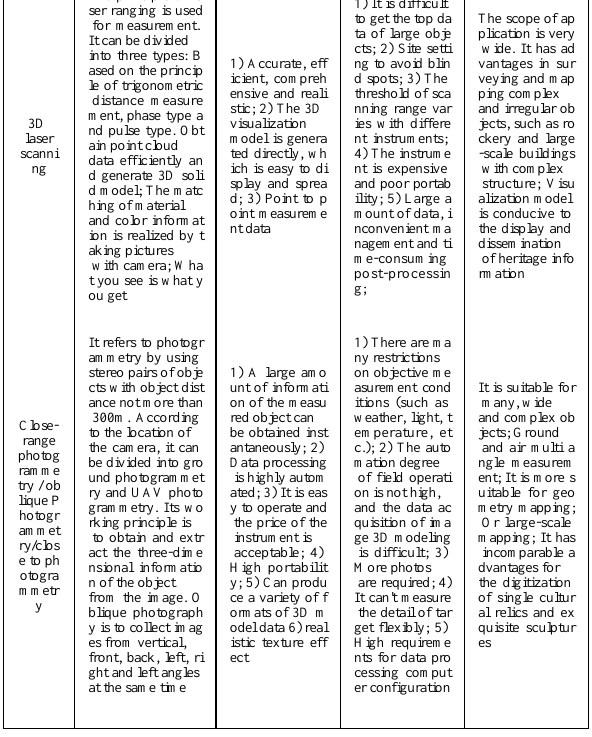
Table 2 . Common types and characteristics of digital surveying and mapping technologies in historical gardens.